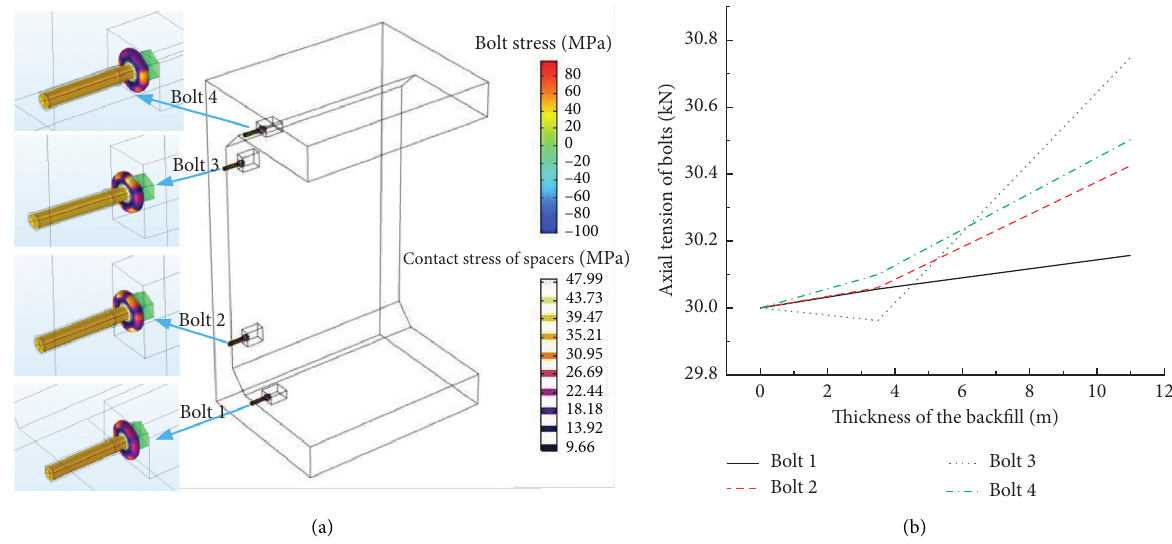
Figure 10: Stress of bolts after backfilling. (a) The number and location of the bolts. (b) Curve of axial force of bolts with backfill soil